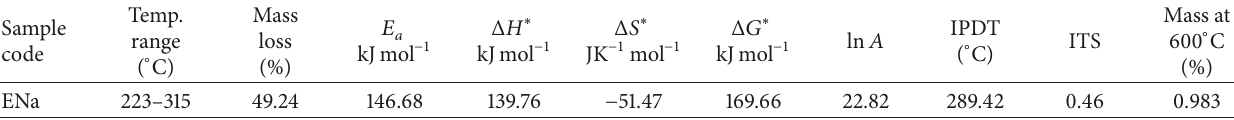
Table 2: Thermal parameters of ENa gel fractions.